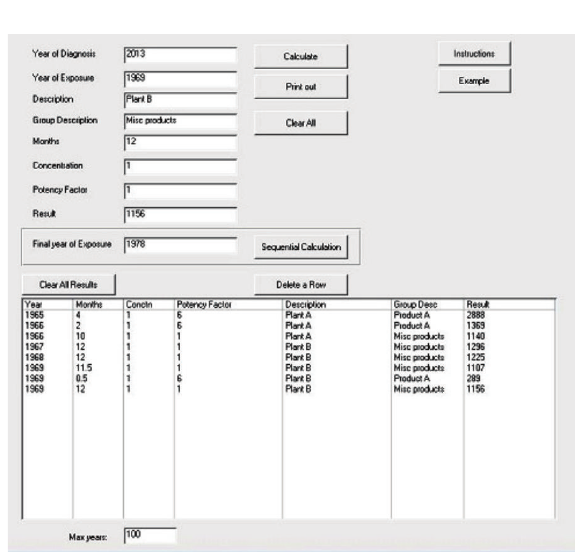
Figure 1: Data input screen. Please see text for description of